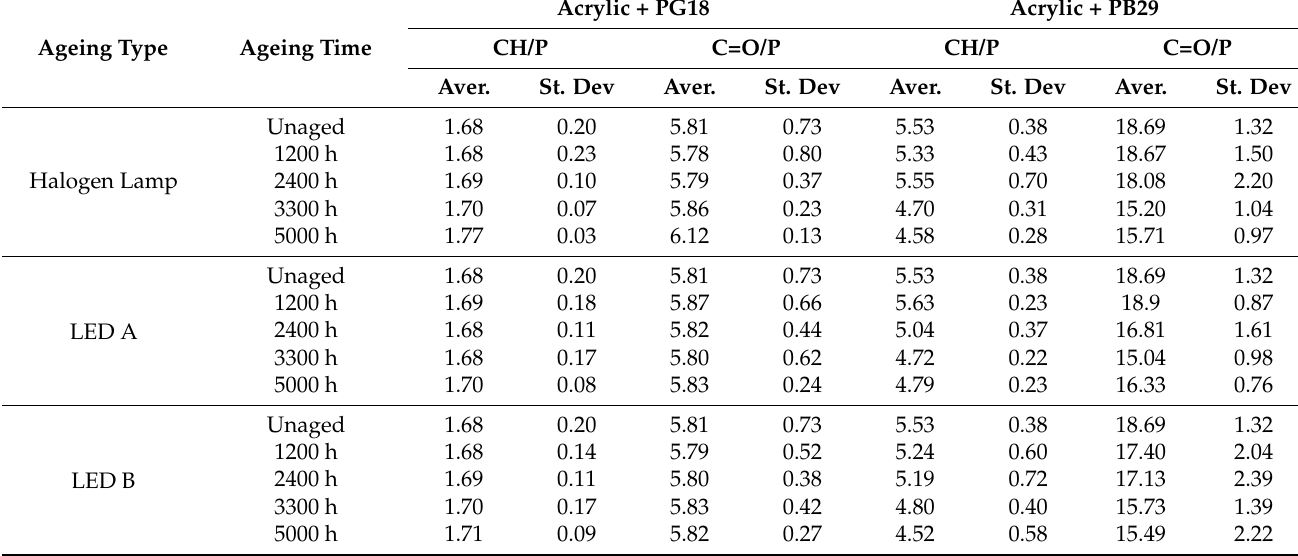
Table 3. Ratios (average—Aver., and standard deviation—St. Dev.) among intensities of CH and C=O IR bands of the alkyd binder (at 2955 and 1726 cm − 1 , respectively) and IR bands of the chrome green PG18 and ultramarine blue PB29 pigments (P), considered between 583 and 456 cm − 1 and between 775 and 610 cm − 1 , respectively. (LED A: 420 nm, LED B: 460